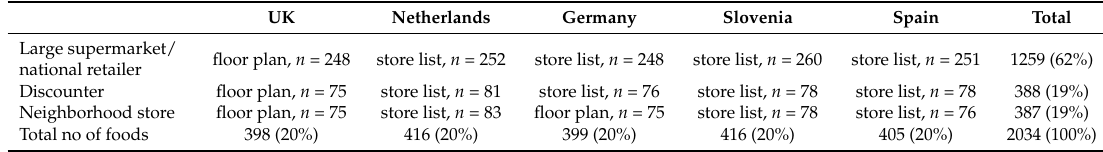
Table 1. Sample overview (sampling method and number of